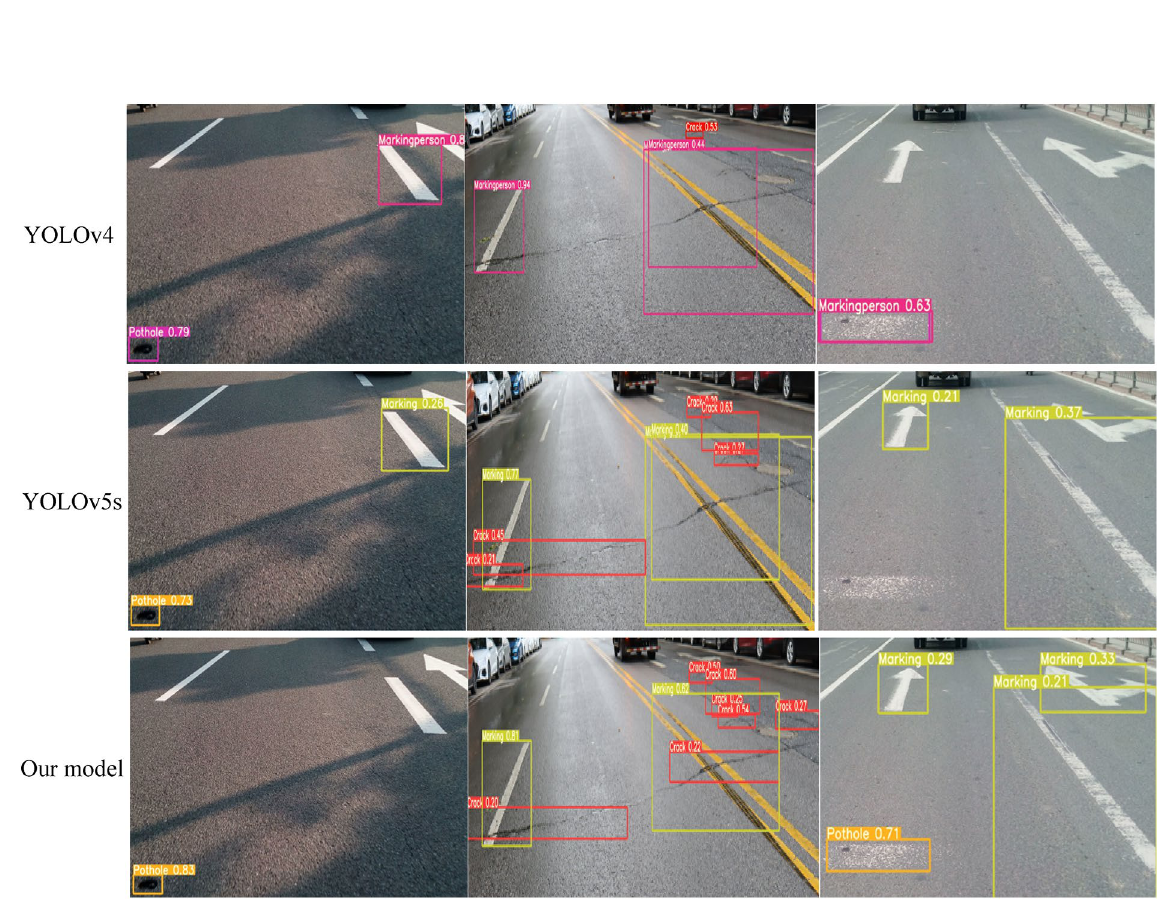
Figure 16. Object recognition results of the improved YOLOv5s